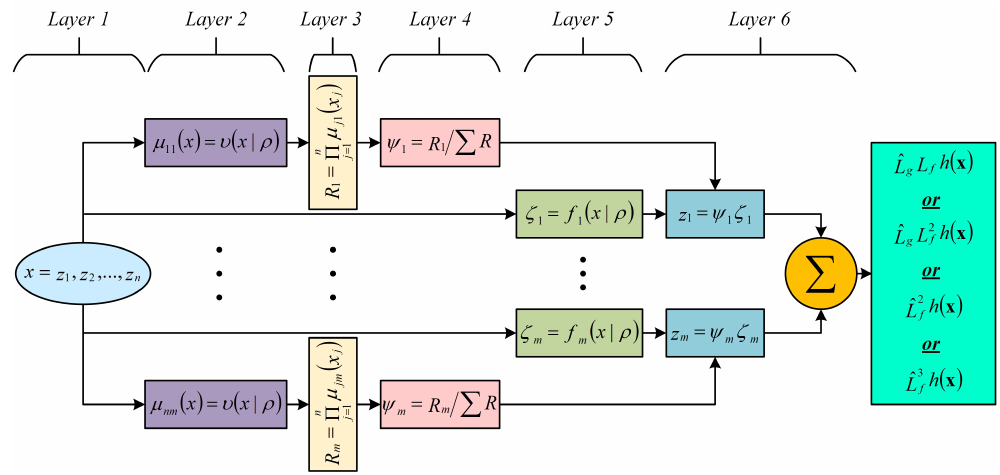
Figure 3. ANFIS network structure for PMSG–WECS Lie-derivatives